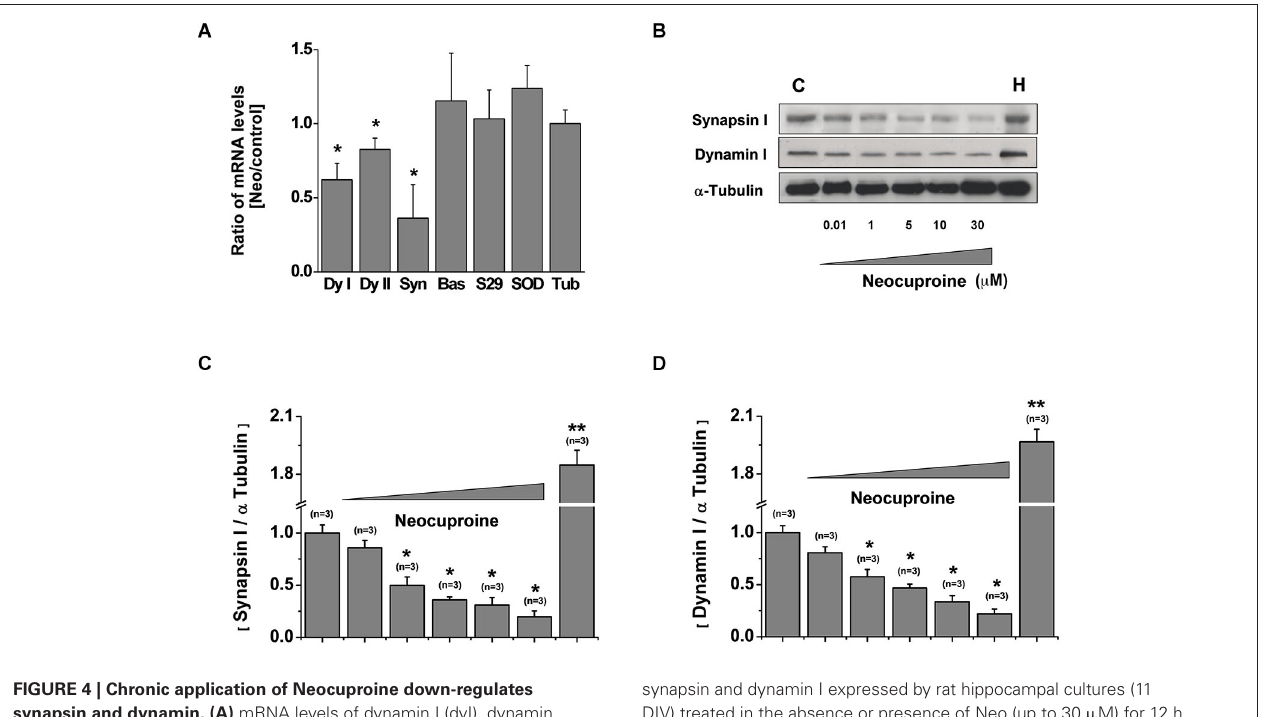
FIGURE 4 | Chronic application of Neocuproine down-regulates synapsin and dynamin. (A) mRNA levels of dynamin I (dyI), dynamin II (dyII), synapsin, Bassoon (Bas), SNAP29, Superoxide Dismutase (SOD) and Tubulin (Tub) expressed by rat hippocampal cultures (11 DIV) treated in the absence or presence of Neocuproine (Neo, 10 µ M) for 12 h. Values are mean ± SEM ( N = 3). *, p < 0.05. (B) Protein levels of